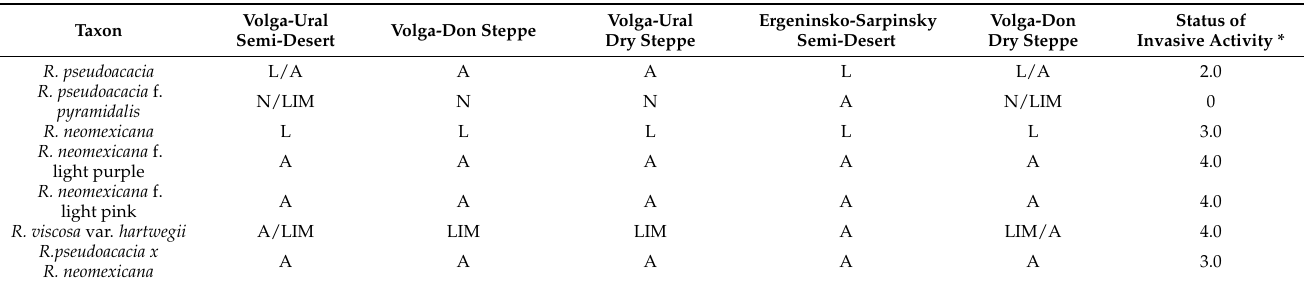
Table 5. The prospects of representatives of the generic complex for various agroforestry districts of the Volgograd region.